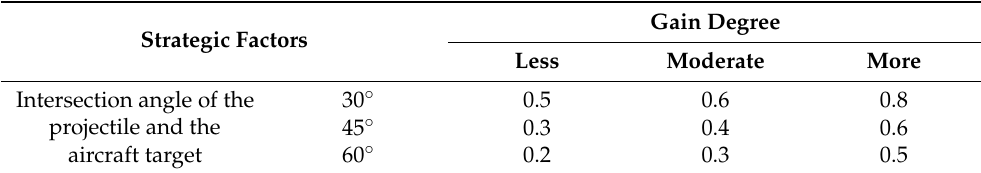
Table 3. The game gain degree under different intersection angles of the projectile and the aircraft